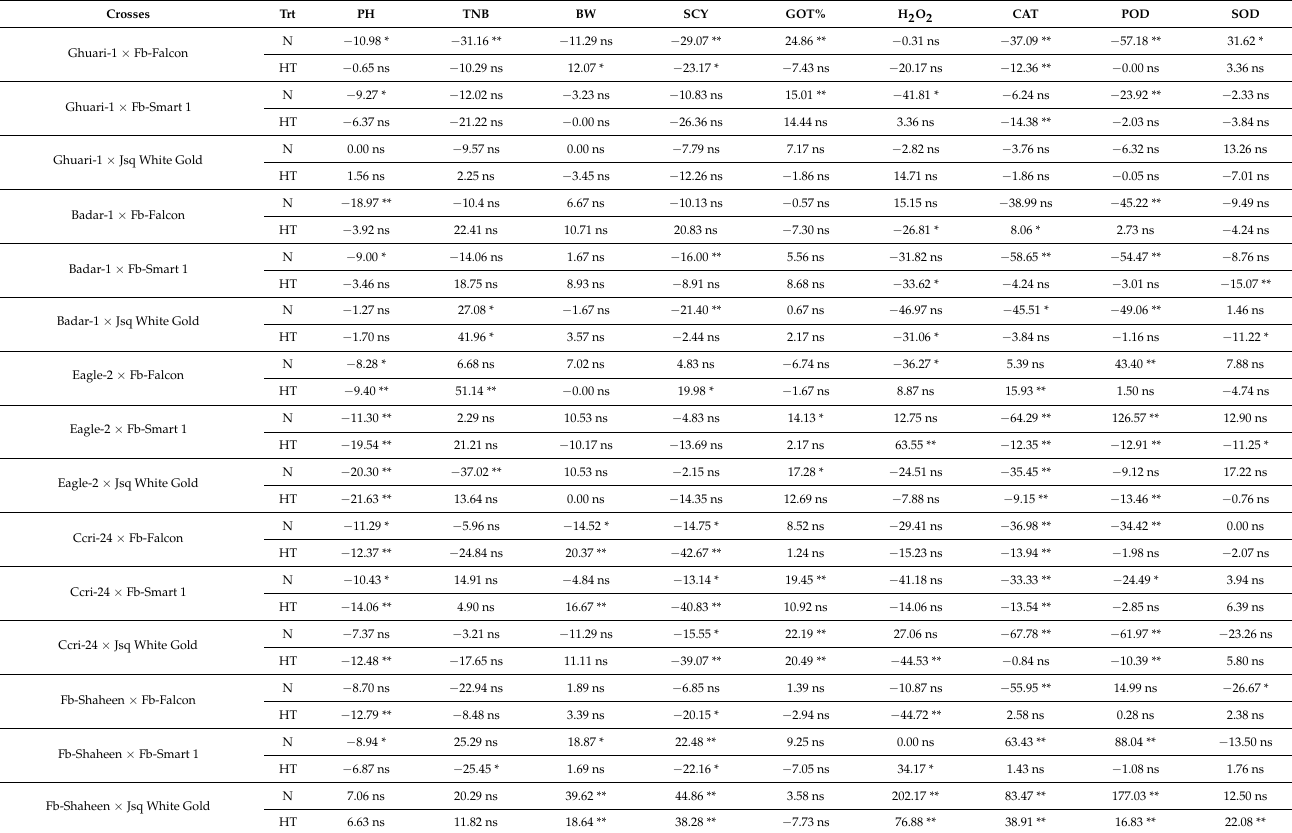
Table 10. First year heterosis effects of various traits under normal and high temperature stress conditions.